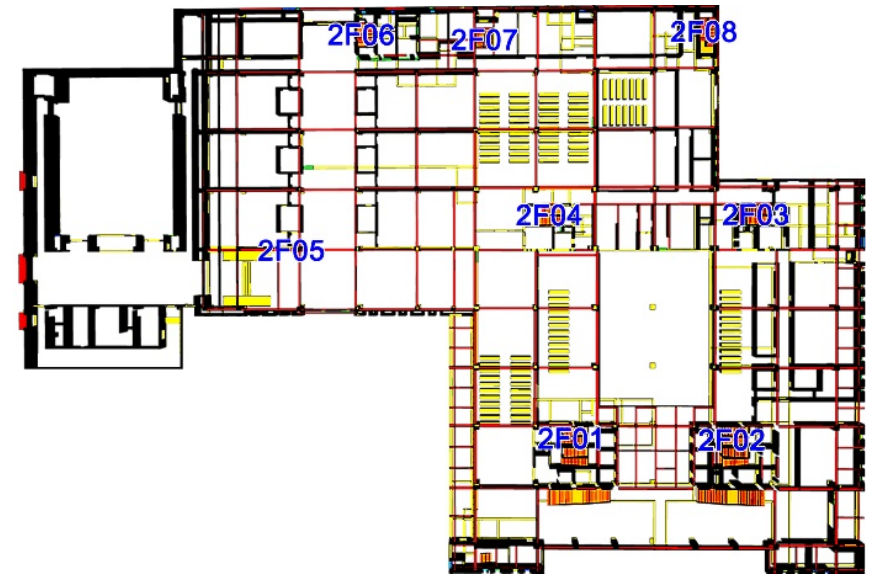
Figure 7. Evacuation passageways on the second floor as an example.